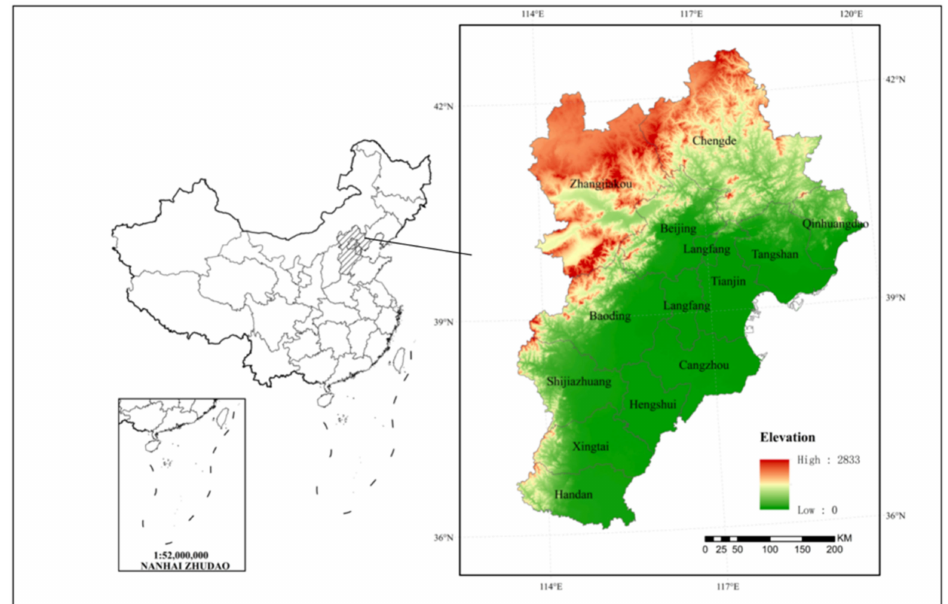
Figure 2. Location of the Beijing–Tianjin–Hebei